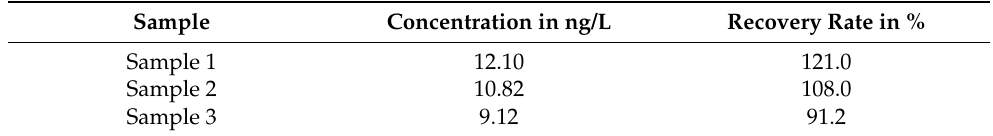
Table 1. Determined platinum concentrations and recovery rates for three independent tap water samples each spiked with 10.0ng/L platinum as measured by HMDE.